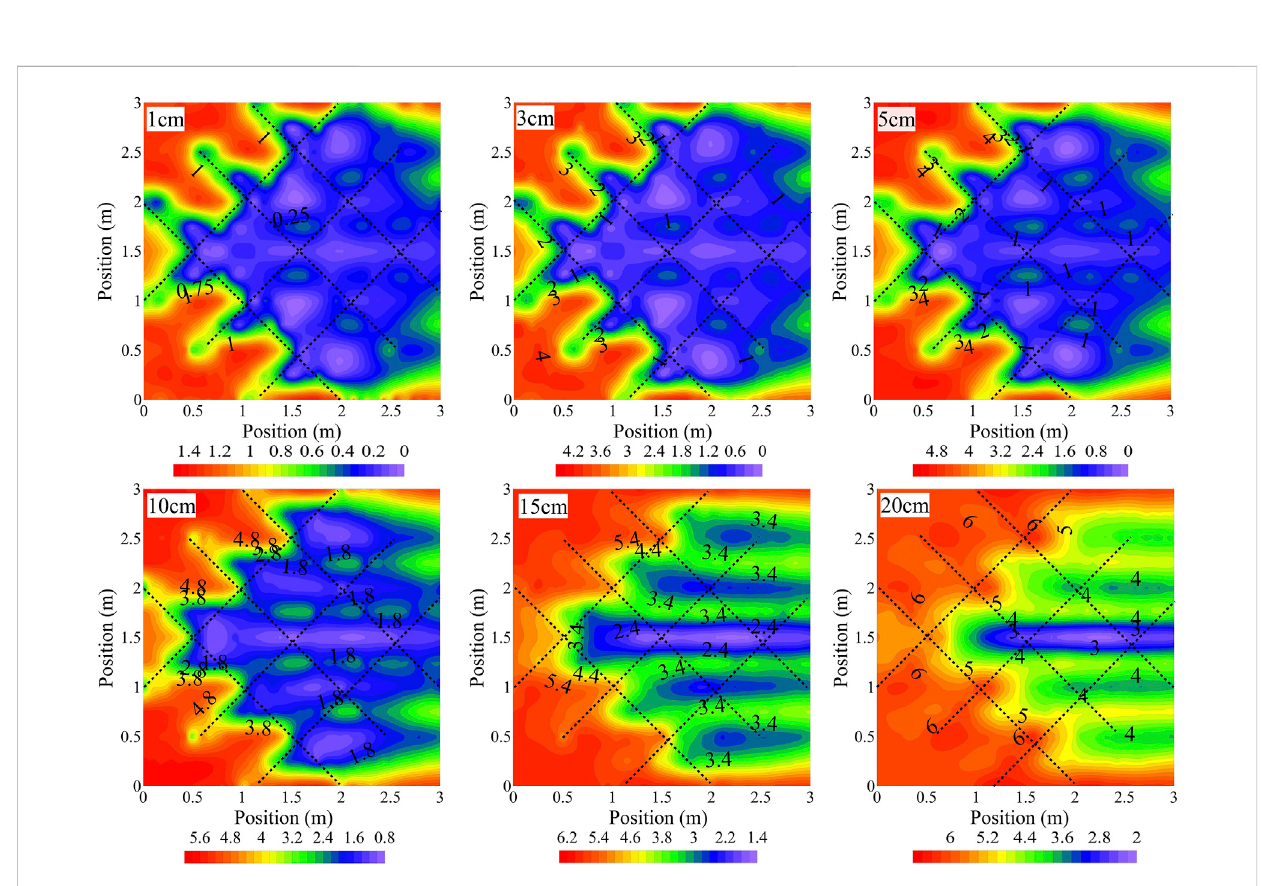
FIGURE 9 Horizontal wind velocity pro fi le speed around 120 ° sand